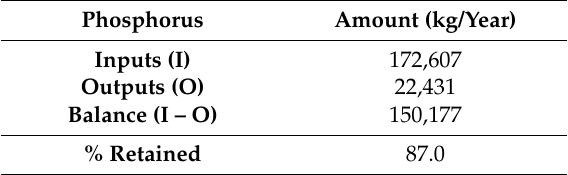
Table 8. Summary of the annual phosphorus budget of the Haean